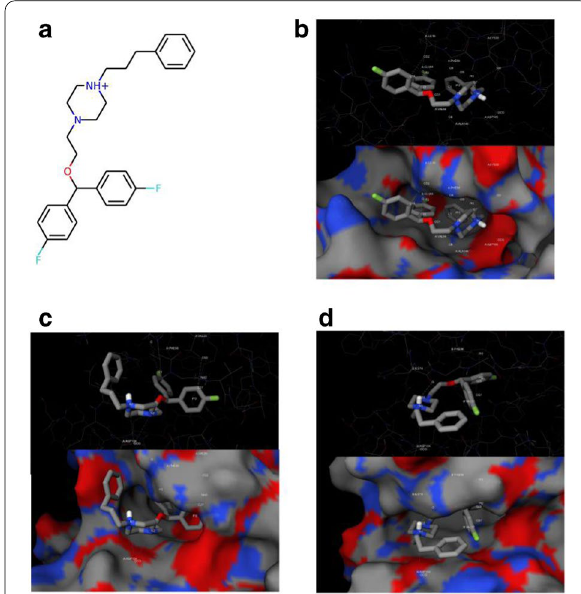
Fig. 6 Structural analysis of the predicted conformation of vanoxerinedihydrochloride in CDK2/4/6 revealed critical binding interactions. a The depicted two‑dimensional structure of vanoxerinedihydrochloride. The predicted binding conformation in complex with b CDK2, c CDK4, and d CDK6. According to the docking result, vanoxerinedihydrochloride binds to CDK2 through hydrophobic contacts with ILE10, LYS33, VAL64, PHE80 and ALA144, a salt bridge with ASP145 and a halogen bond with GLU81. It interacts with CDK4 through two salt bridges with ASP104, a π interaction with LYS40, and a halogen bond with PHE98. It binds to CDK6 through a hydrogen bond with ILE19, a salt bridge with ASP104 and a π interaction with